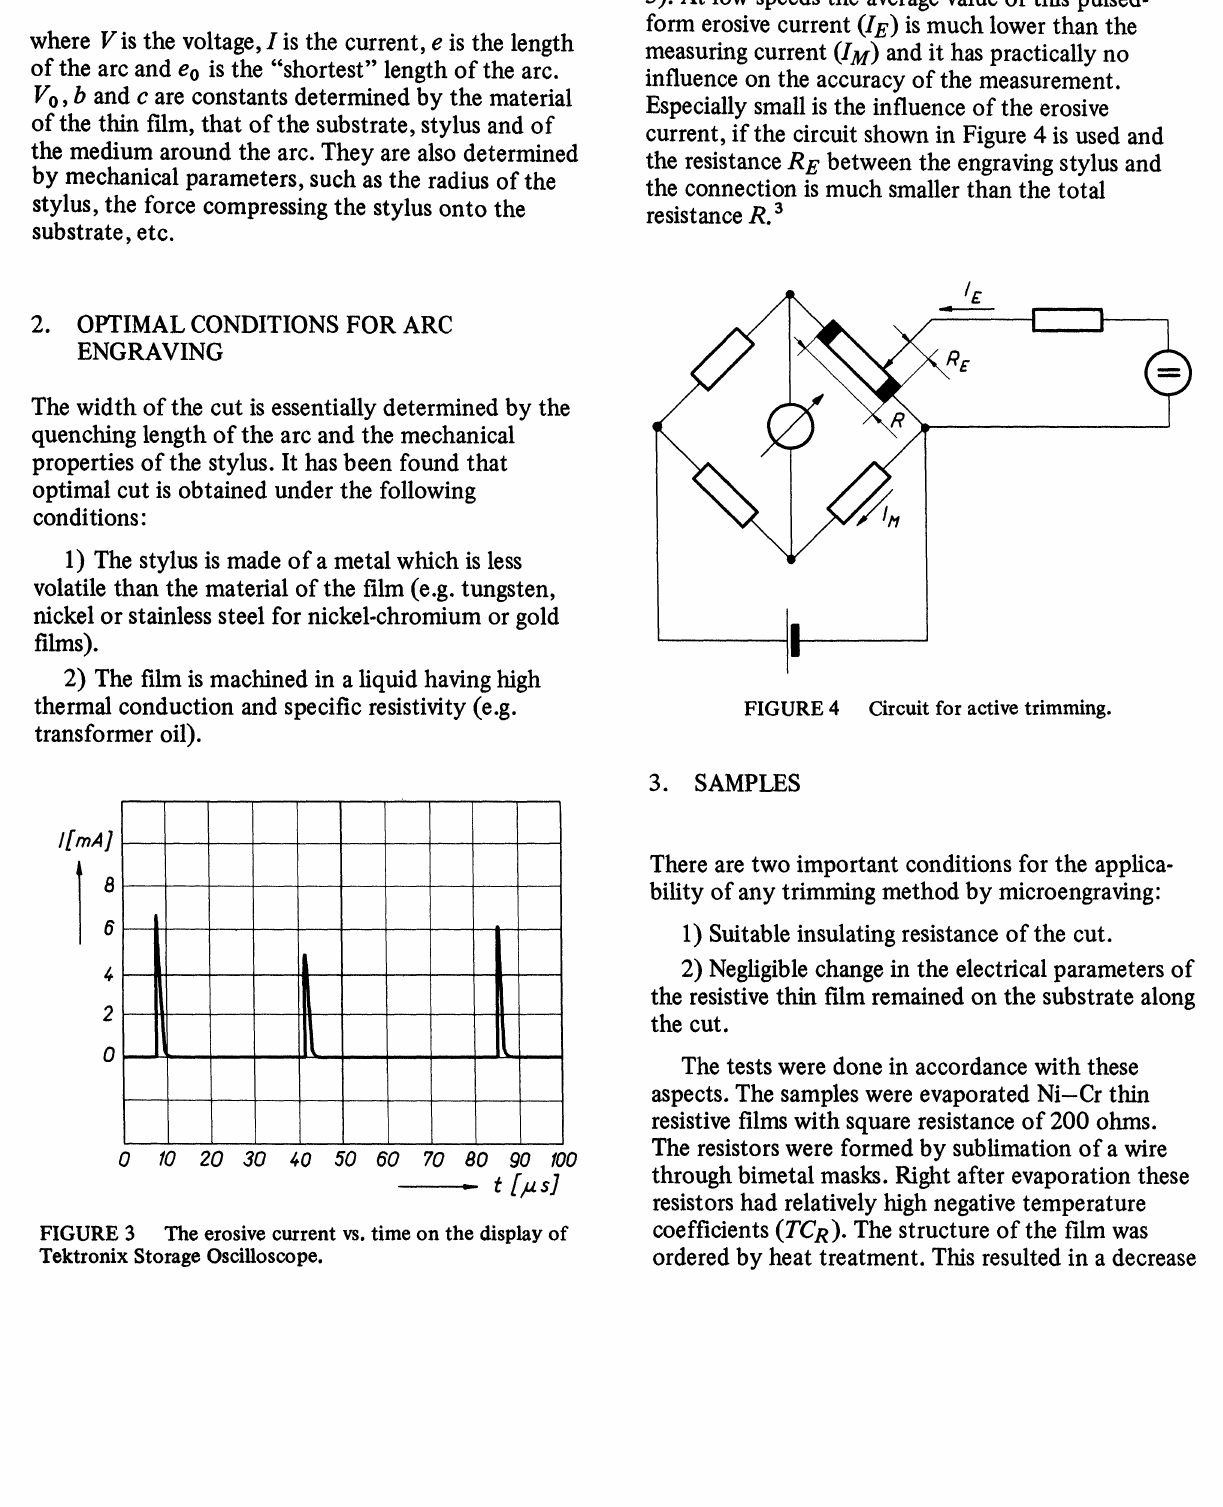
The erosive current vs. time on the display of Tektronix Storage Oscilloscope.